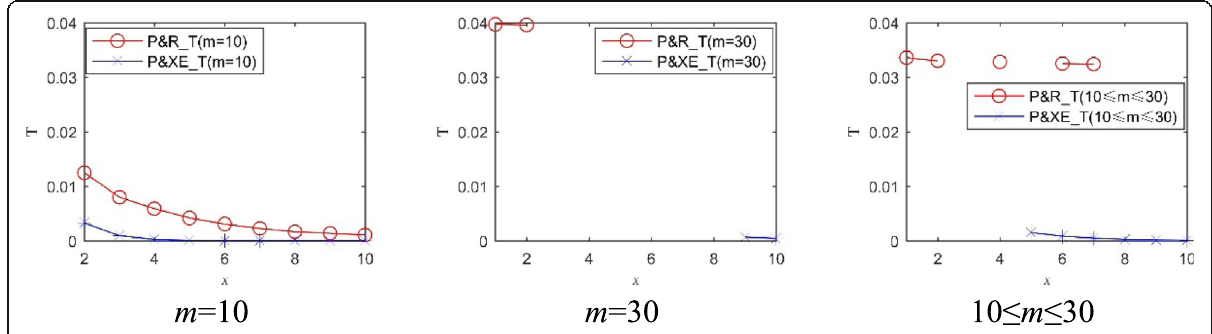
Fig. 5 Data security comparison under the same C * and O * constraints for n =